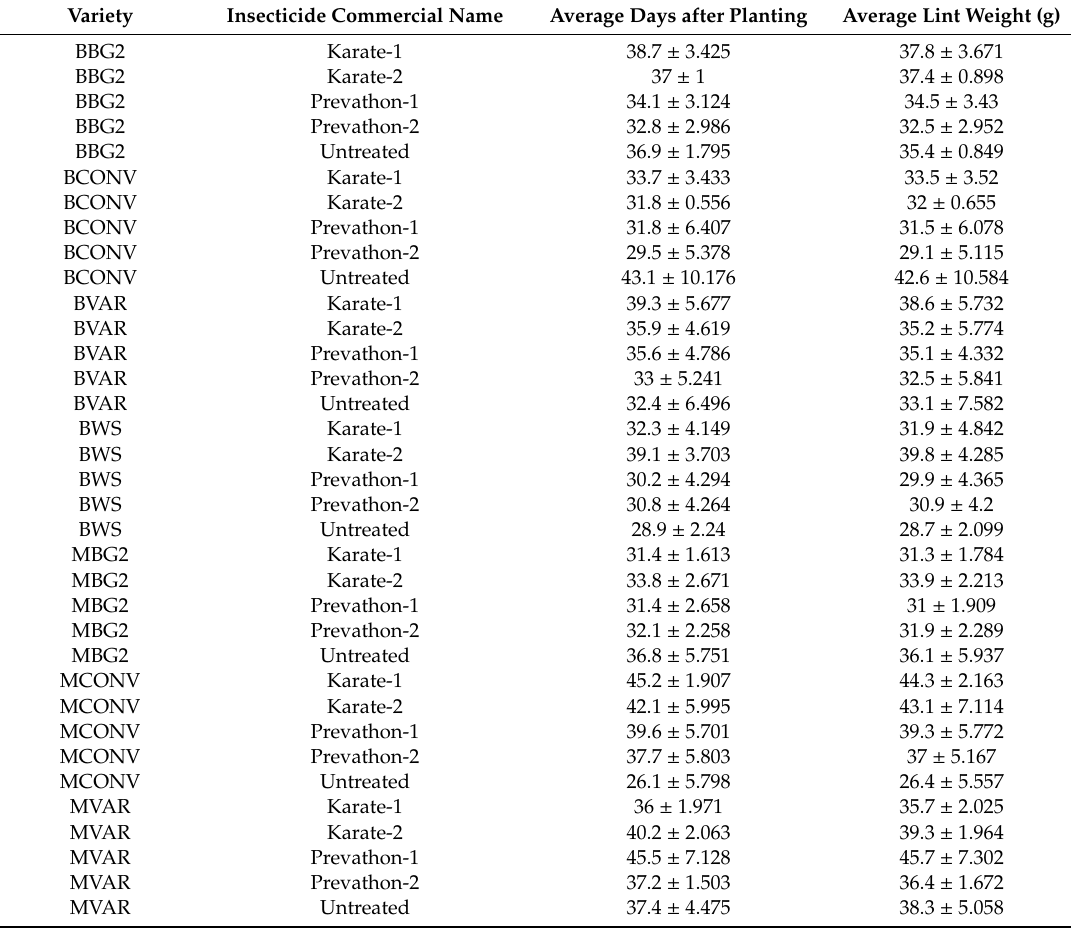
Table 10. Average days after planting ± SEM of fruit initiation per surviving fruit and g of lint harvested in 2012 box